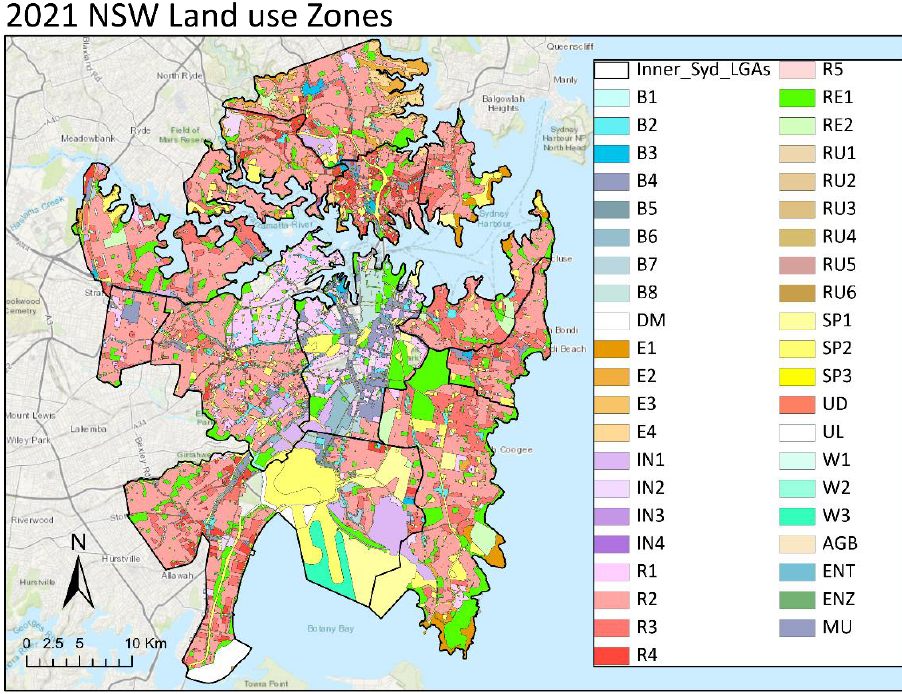
Figure 6. NSW Land use zones in